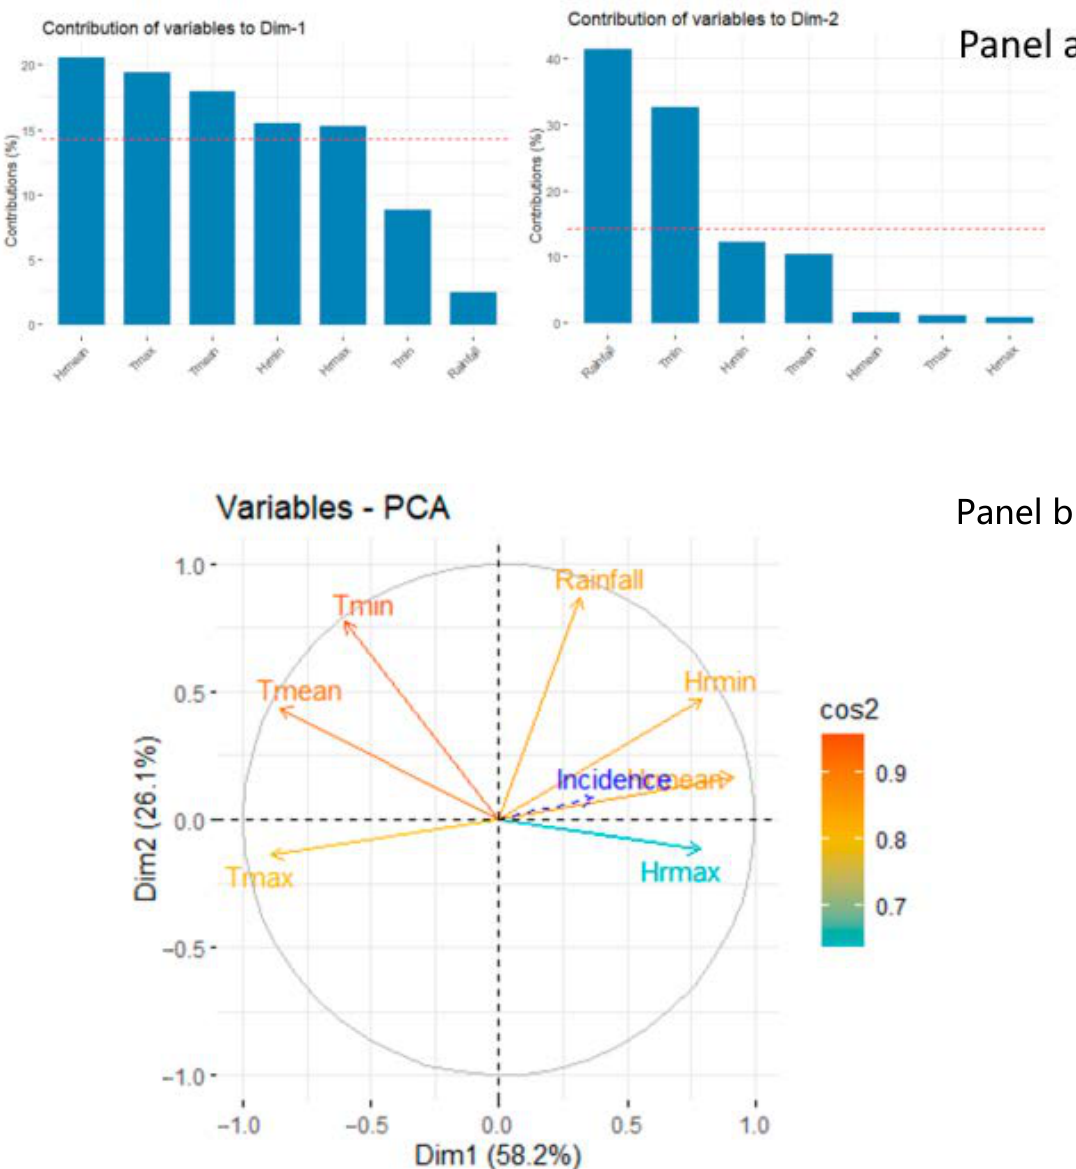
Figure 3. Graph of PCA with the contribution of meteorological variables: ( a ) Sahel zone; ( b ) Sudano-Guinean zone.